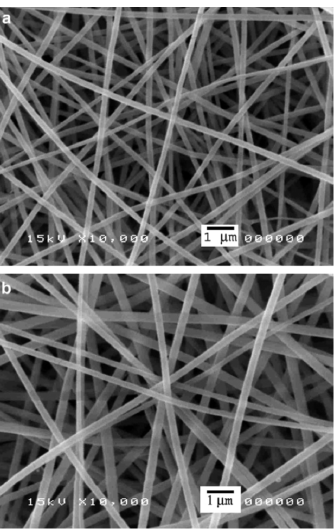
Figure 2. SEM images of the electrospun fiber mats from ( a ) the base gelatin solution and ( b ) the AgNO 3 -containing gelatin solution that had been aged for 12 h. Figure from Rujitanaroj et al. [27] Copyright (2021), with permission from